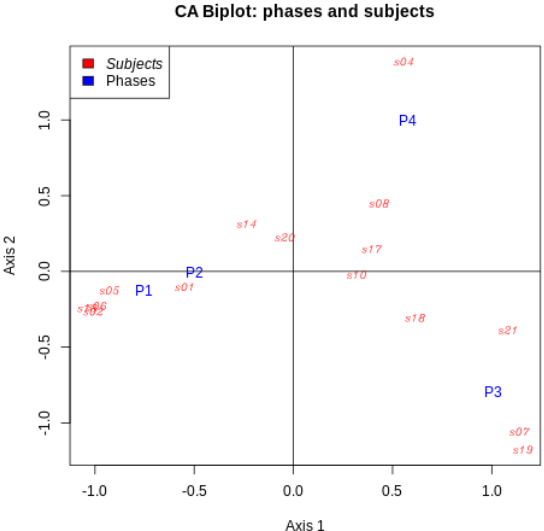
Figure 4. First principal plane of correspondence analysis. Phases 1 to 4 are represented by blue points labelled as P1 to P4. Partic- ipants 1 to 21 are represented by red points labelled as s01 to s21.